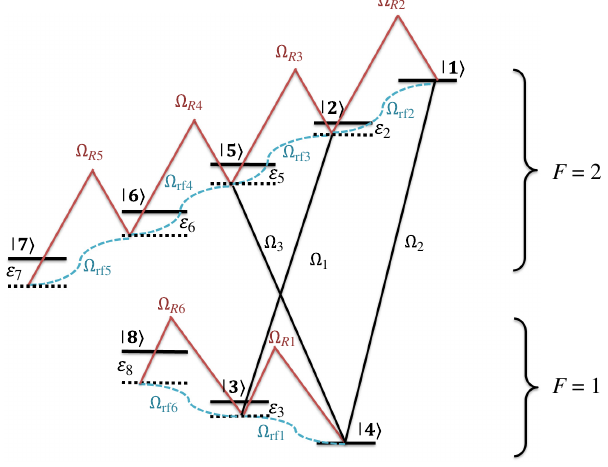
FIG. 12. Level diagram of 87 Rb and light couplings. Schematic of the eight spin states | 1 (cid:2) ,..., | 8 (cid:2) in the F = 1 and F = 2 hyperfine manifolds. Here (cid:2) R 1, ... , R 6 are Raman couplings, (cid:2) (cid:2) 1,2,3 are microwave couplings, rf1, ... ,rf6 are rf couplings, and | 1 (cid:2) ,..., | 8 (cid:2) in ε 1,..,8 are respective “site energies” for spin states the synthetic